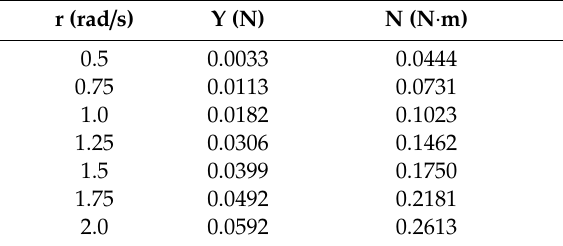
Table 8. Measurements of vertical force Y and pitching moment N at di ff erent angular velocities r.